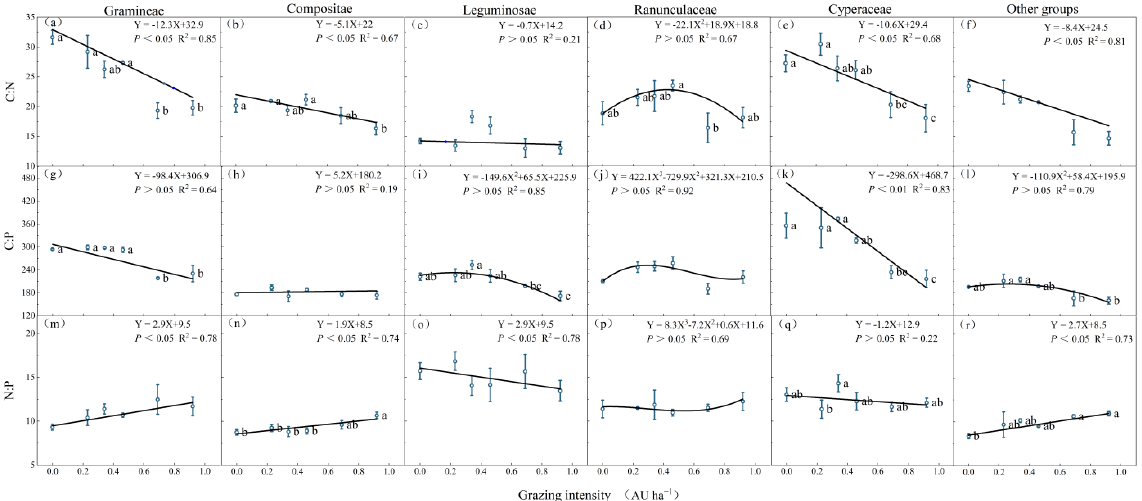
Figure 3. Variation in C/N ( a – f ), C/P ( g – l ) and N/P ( m – r ) ratios of plant functional groups under different grazing intensities. Note: Lowercase letters represent significant differences between different grazing intensities ( p < 0.05).